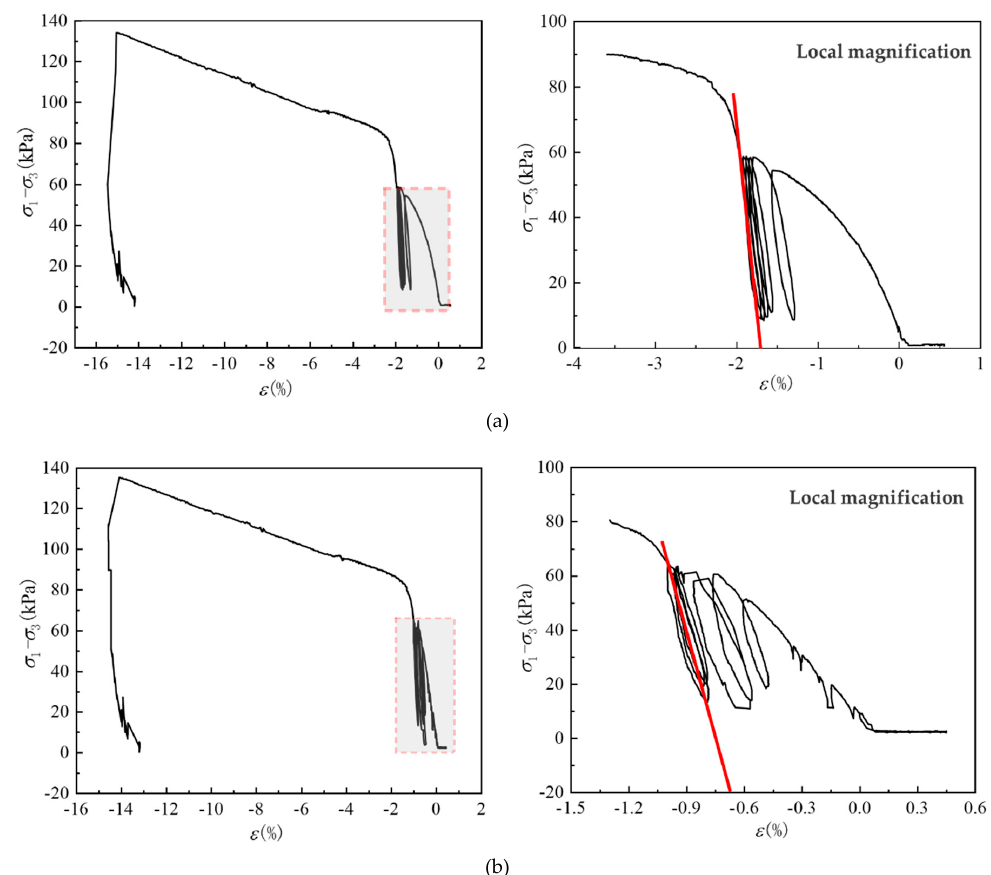
Figure 3. Physical properties test of loess filler.